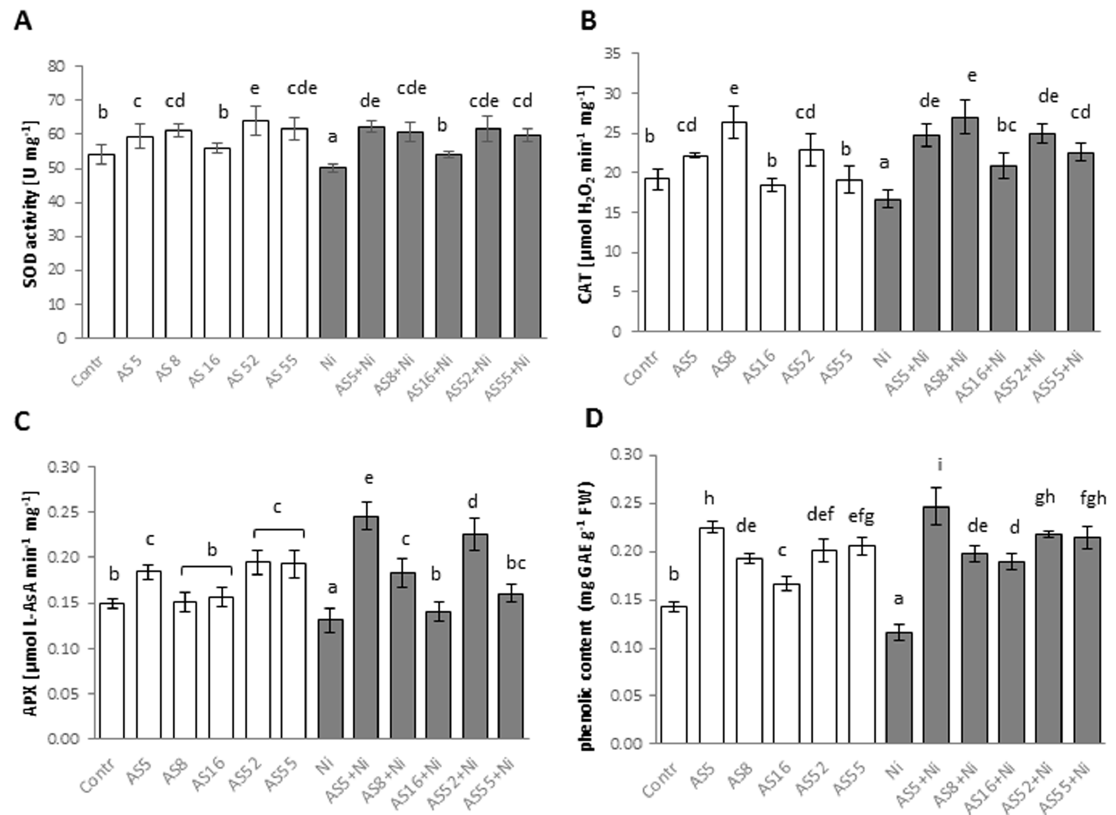
Figure 10. The activities of selected antioxidant enzymes and phenolic compound content in 4-week- old Arabidopsis plants, non-exposed (bars in white) and exposed to 200 µM Ni (bars in grey), in the absence or presence of rhizobial strains. ( A ) SOD, superoxide dismutase activity; ( B ) CAT, catalase activity; ( C ) APX, ascorbate peroxidase activity; ( D ) phenolic content. Values are means (±SD) of 10 plants per isolate from two independent experiments. The same letters indicate the homogenous groups according to the Tukey HSD test at the level p =